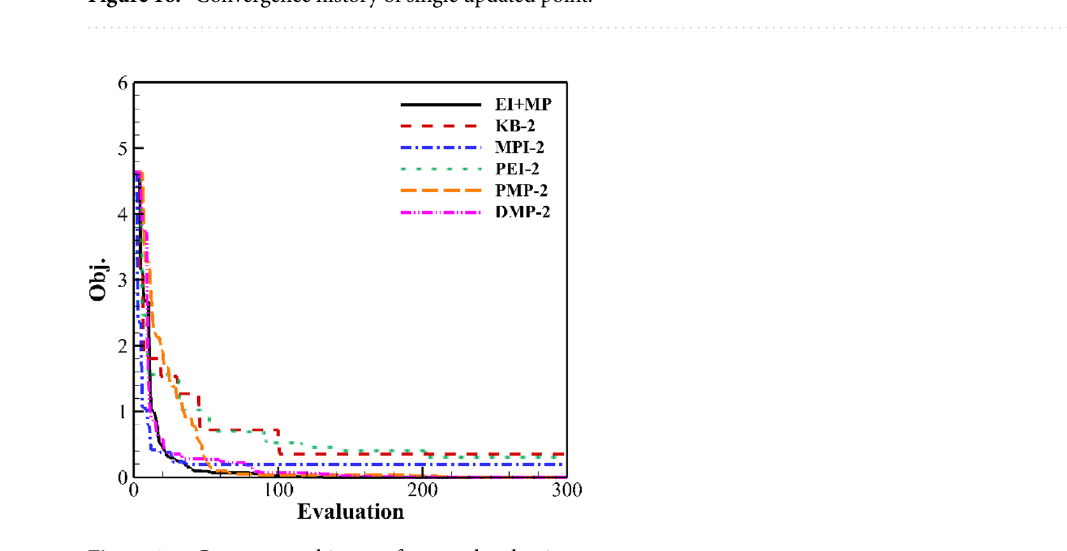
Figure 17. Convergence history of two updated points.